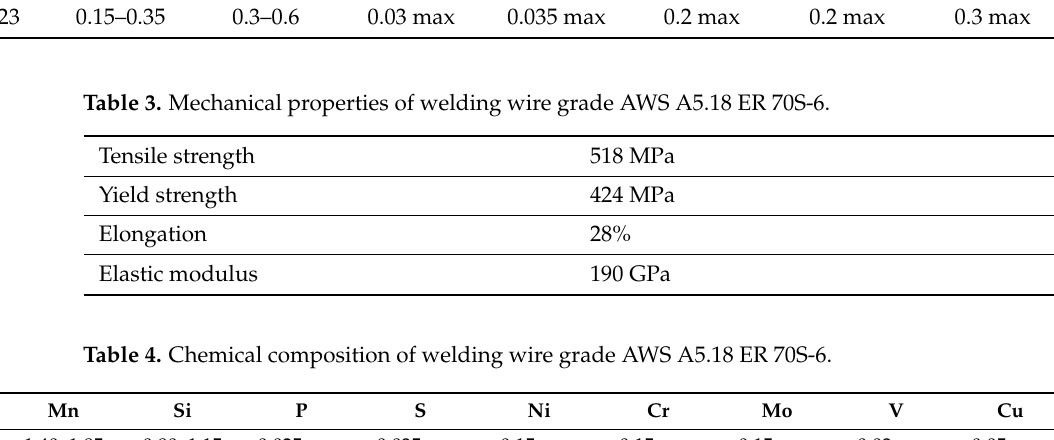
Table 4. Chemical composition of welding wire grade AWS A5.18 ER 70S-6.